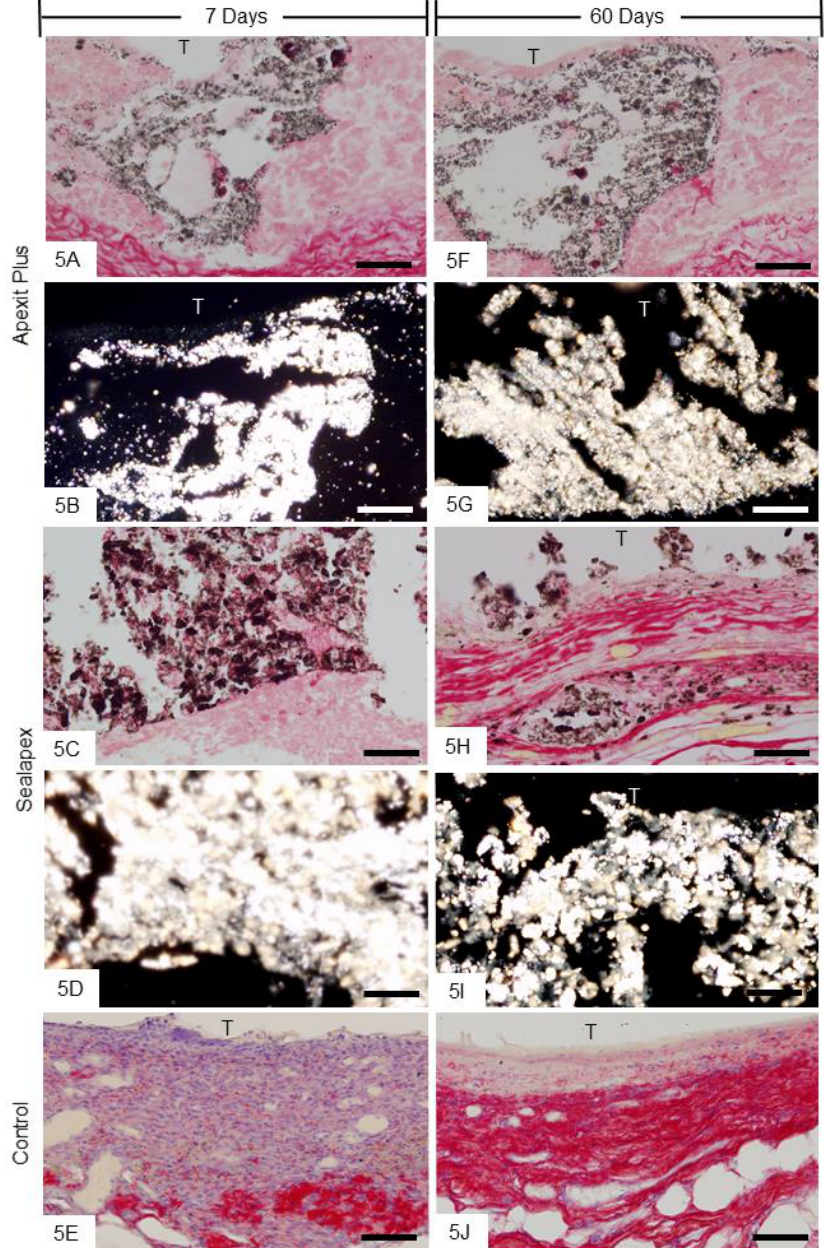
Figure 5. Photomicrographs show capsules next to the opening of the tubes. A,C,E,F,H,J The von Kossa histochemical method and Picro Sirius red; von Kossa-positive structures (black) are present in Apexit Plus ( A,F ) and Sealapex ( C,H ) groups. Note that no von Kossa-positive structure is observed in control specimens ( E,J ). B,D,G,I Light micrographs showing unstained sections analyzed under polarized light. The capsules of Apexit Plus ( B,G ) and Sealapex ( D,I ) groups exhibit birefringent structures. T, space of the implanted tube. Bars: 25 µm.